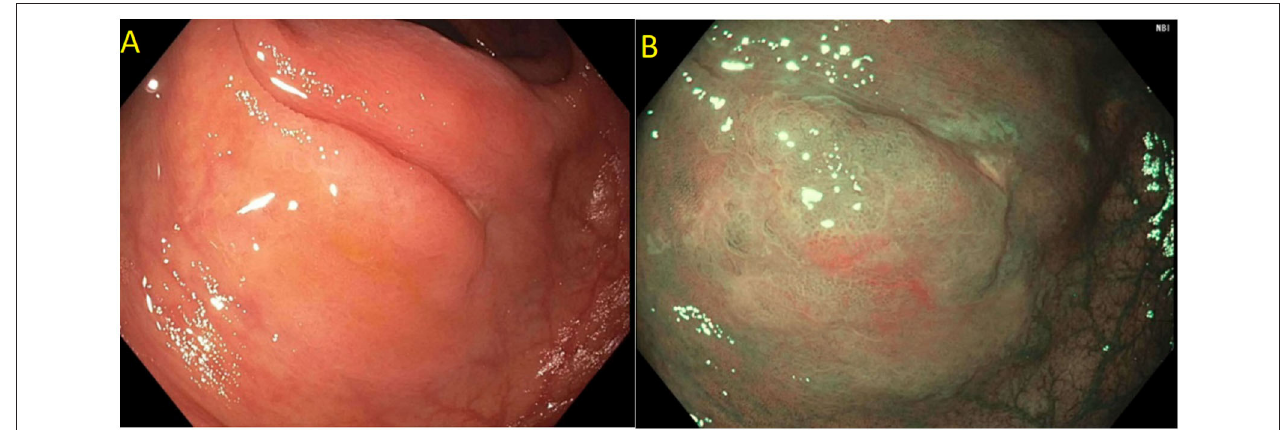
FIGURE 5 | Sessile serrated polyp on white light (A) and narrow band imaging (B) . Polyp lacks a brown coloration and blood vessels or a tubular/branched surface pattern seen with tubular adenomas. Features of SSPs include clouded surface, indisctinctive borders, irregular shape, dark spots inside crypts, and mucus